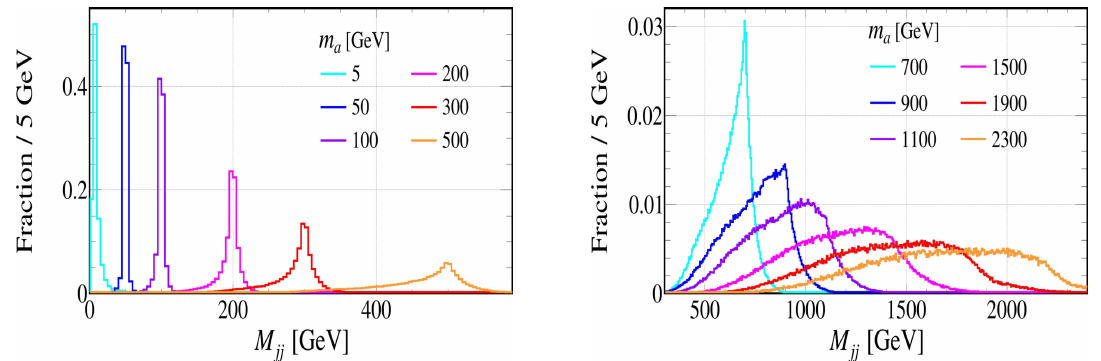
Figure 5 . Reconstruction of the invariant mass of ALPs for various representative ALP mass assumptions. The histograms represent distributions of invariant mass constructed from a jet pair in an event whose combined invariant mass is closest to the assumed ALP mass. The parameter C ˜ /f a is fixed at 10 − 2 TeV − 1 for all signal G